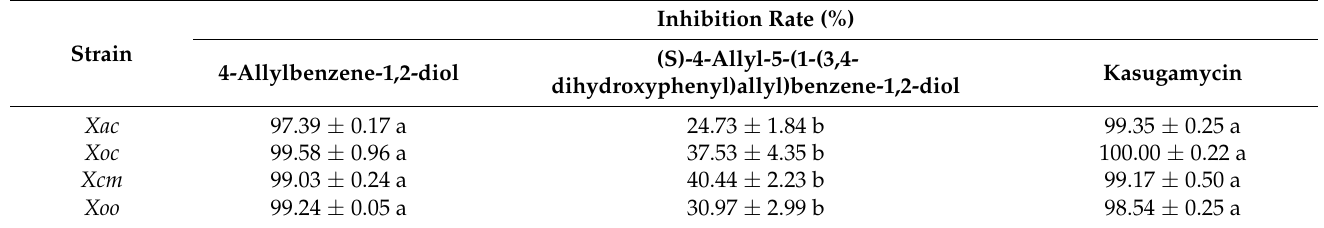
Table 1. Antibacterial activities of isolated compounds from Piper austrosinens against four phytopathogenic bacteria (concentration: 1000 μ mol/L).